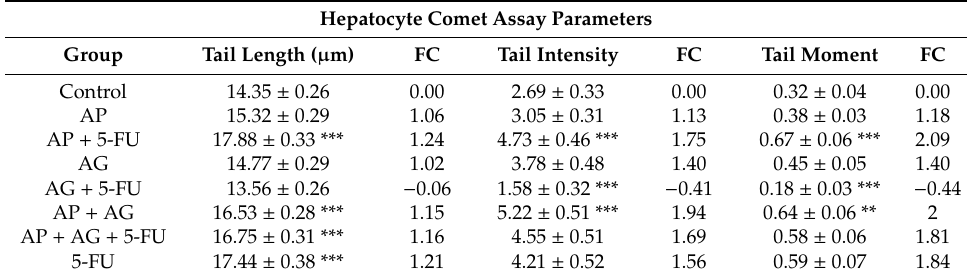
Table 8. E ff ect of treatment with Agarikon Plus, Agarikon.1 and 5-fluorouracil in various combinations on comet assay parameters as an indicator of DNA damage on hepatocytes in Balb / c